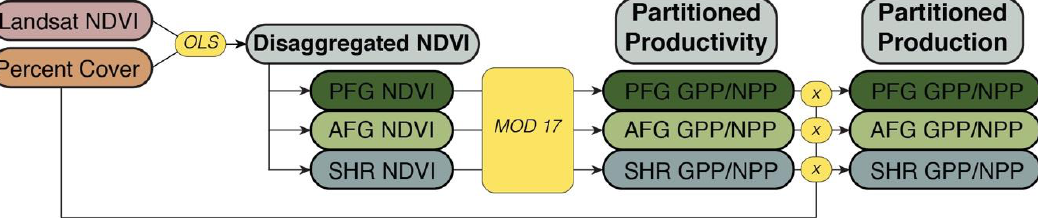
Figure 3. Flow chart of the methodological steps to calculate partitioned gross primary production (GPP) and net primary production (NPP) by integrating the Landsat NDVI composite product and the annual plant functional type (PFT) percent cover dataset for perennial forbs and grasses (PFG), annual forbs and grasses (AFG) and shrubs.